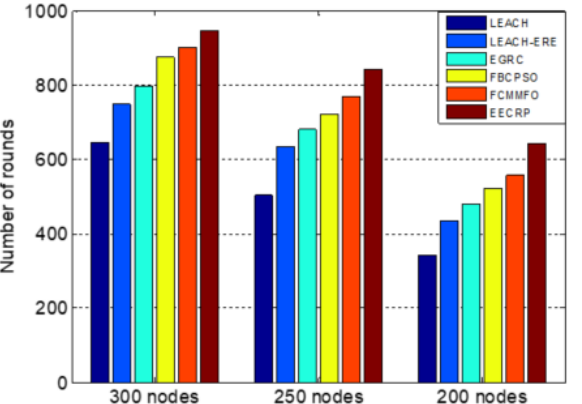
Figure 12. The number of rounds when the energy is exhausted under the different number of nodes.